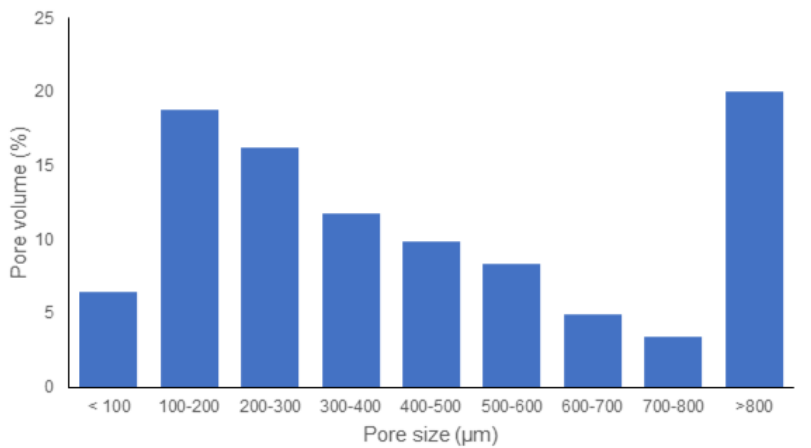
Figure 5. Pore size distribution in 1d-derived scaffolds assessed by micro-CT measurement.